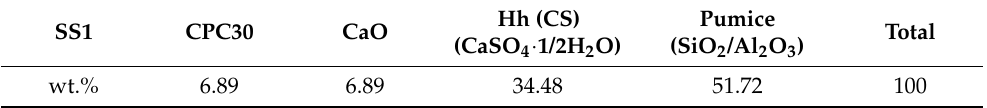
Table 2. Composition (wt.%) of SS1 supersulfated cement based on pumice, hemihydrated Ca-sulfate (Hh), cement CPC30 and CaO [21].